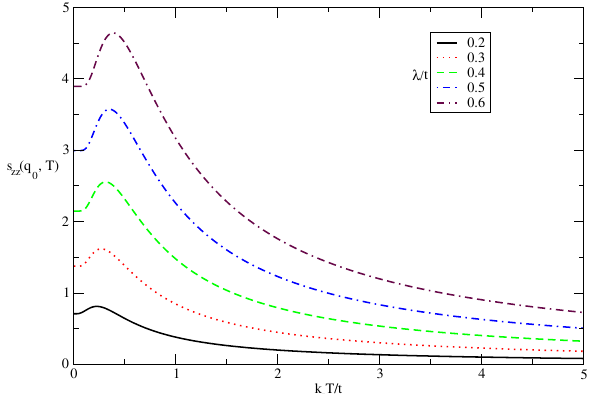
Figure 6. The longitudinal static spin structure factor s zz ( q 0 , T ) of undoped Germanene layer versus normalized temperature k B T / t for different values of spin-orbit coupling strength (cid:31) / t in the absence of magnetic field.